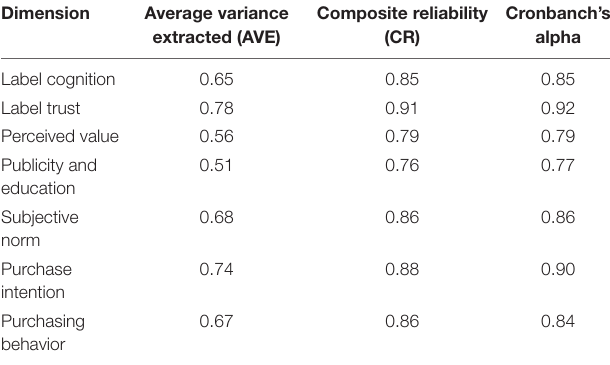
TABLE 3 | Reliability test results of the